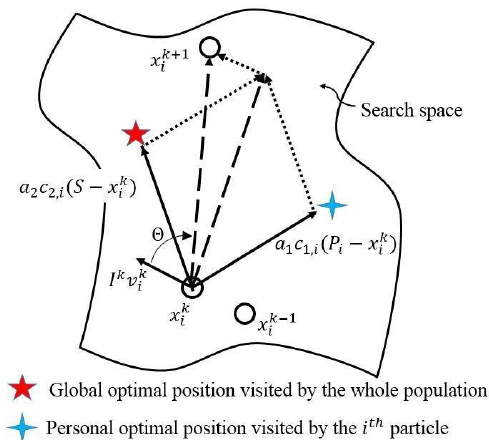
Figure 1. Criteria of the searching in the particle swarm optimization (PSO).